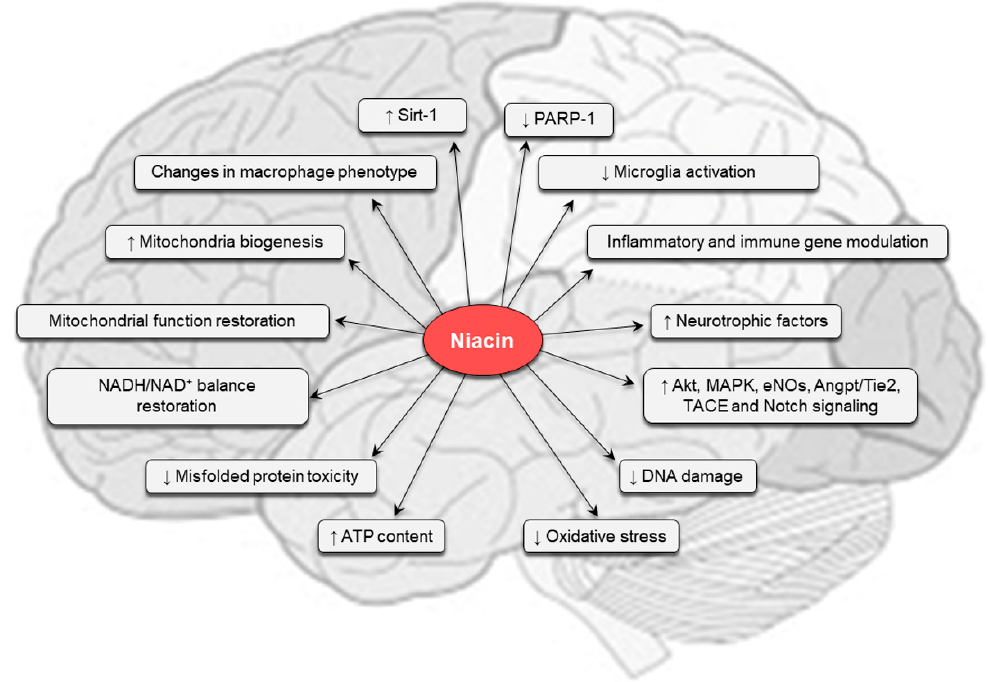
Figure 4. Main molecular mechanisms underlying beneficial effects of niacin in the CNS under physio-pathological